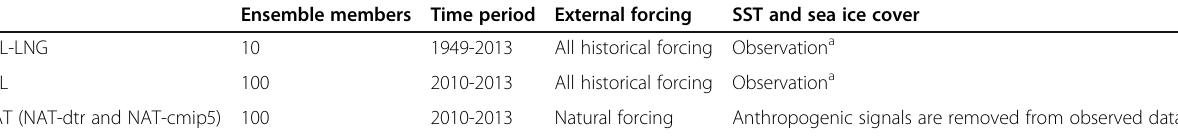
Table 1 Summary of event attribution climate experiments. SST, sea surface temperature; ALL, large-ensemble climate experiment with anthropogenic radiative change; ALL-LNG, ALL experiment forcing long period runs; NAT, large-ensemble climate experiment without anthropogenic radiative